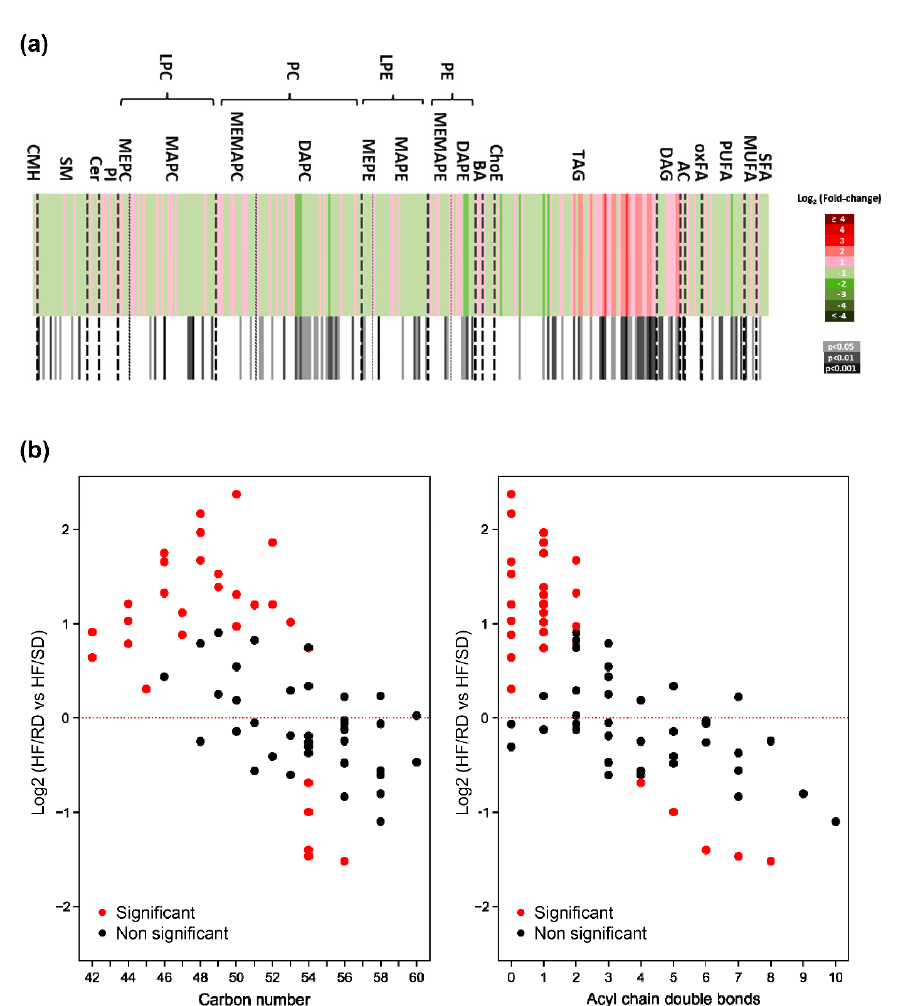
Figure 2. Rat liver lipidome. ( a ) Heat map showing relevant changes in liver lipids. Each metabolite is shown as a line whose color is defined by the sign and magnitude of the change. Adjacent column to each comparison shows the results of the t test ( p value). Color scales are shown in the right: upper scale, Log2 fold-change; lower scale, statistical significance ( n HF–SD = 7, n HF–RD = 8). BA, bile acids; Cer, ceramides; CMH, monohexosyl ceramide; ChoE, cholesterol esters; DAGs, diglycerides; DAPC, diacylglycerophosphocholine; DAPE, diacylglycerophosphoethanolamine; oxFA, oxidized free fatty acids; LPCs, lysophosphatidylcholines; LPEs, lysophosphatidylethanolamines; MEPC, 1-Monoetherglycerophosphocholine; MAPC, MonoacylglyceroPhosphocholine; MEMAPC, 1-ether, 2-acylglycerophosphocholine; PCs, phosphatidylcholines; PEs, phosphatidylethanolamines; PIs, phosphatidylinositols; MUFAs, monounsaturated fatty acids; PUFAs, polyunsaturated fatty acids; SFAs, saturated fatty acids; SMs, sphingomyelins; TAGs, triacylglycerols. ( b ) Correlation of HF–RD vs. HF–SD fold-change with TAG carbon number (left), and with acyl chain double bonds